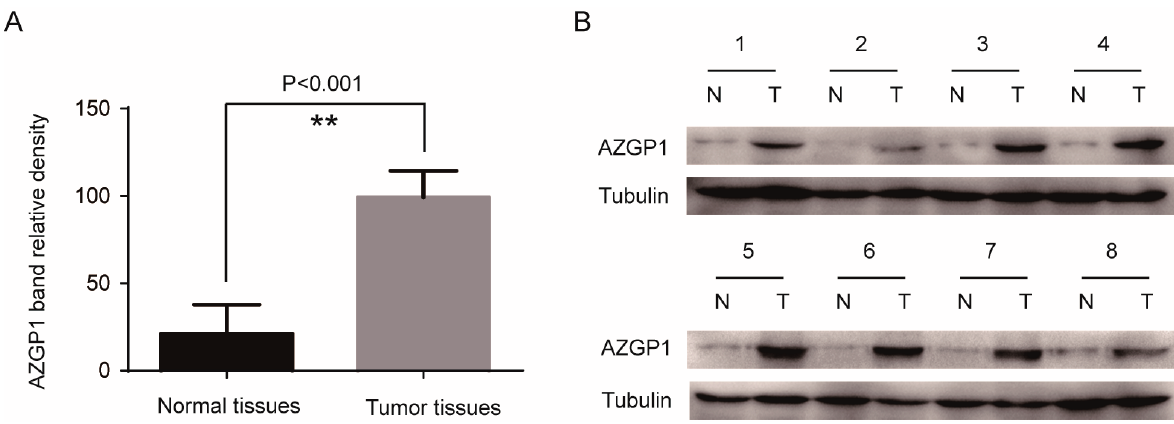
Figure 2. Upregulation of AZGP1 expression in colon cancer at the